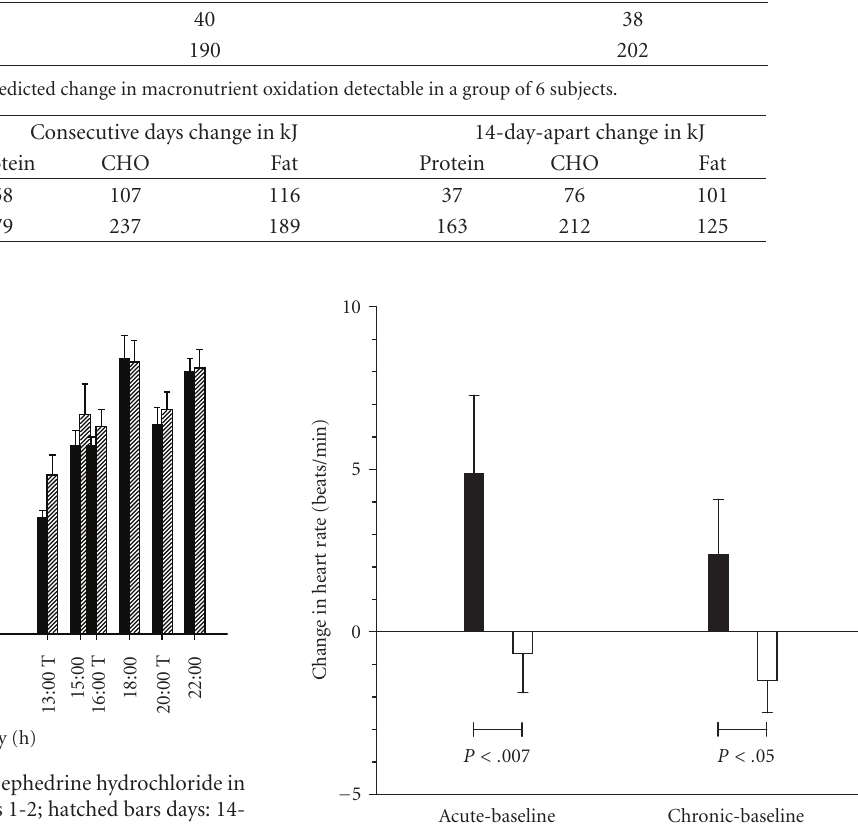
Figure 4: Influence on 22.5-hour average heart rate of acute or chronic (14 day) treatment with ephedrine hydrochloride (solid bars) or placebo (open